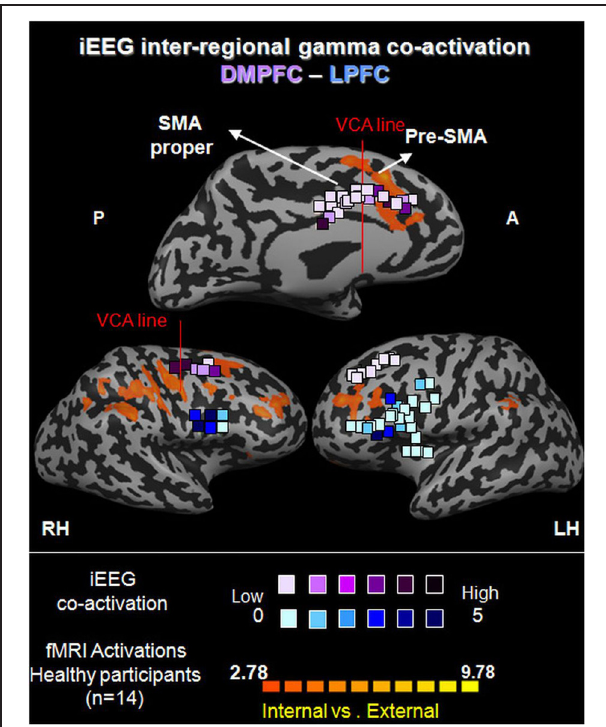
FIGURE 8 | Functional iEEG co-activation in epileptic patients (67 electrodes) in gamma (31–60Hz). Electrodes are shown on healthy participants’ fMRI activation maps of the direct contrast between internally and externally generated action planning ( n = 15, P < 0.015, random effect, uncorrected). The marked electrodes in the DMPFC and LPFC (purple and blue, respectively) show significantly increased inter-regional gamma co-activation for internally compared to externally guided simple finger tapping. The color of each electrode indicates the number of significant connections it has with electrodes from the other